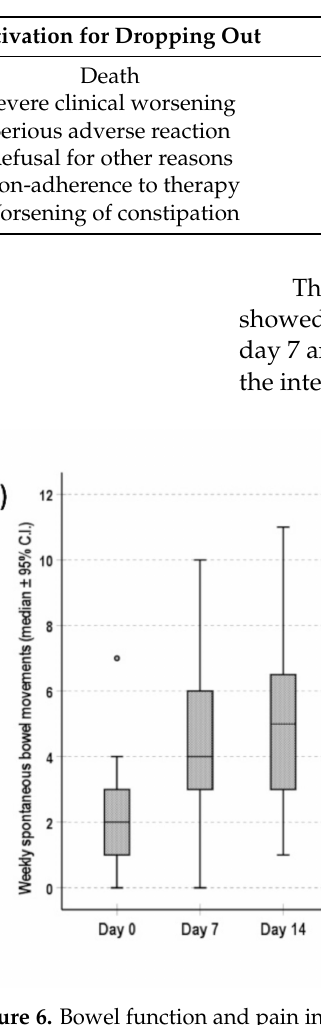
Table 2. Motivation for dropping out in the study population.